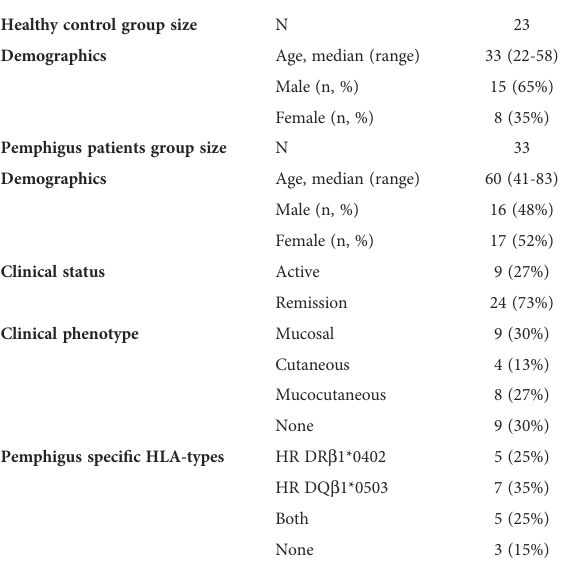
TABLE 1 Characteristics of pemphigus patients and